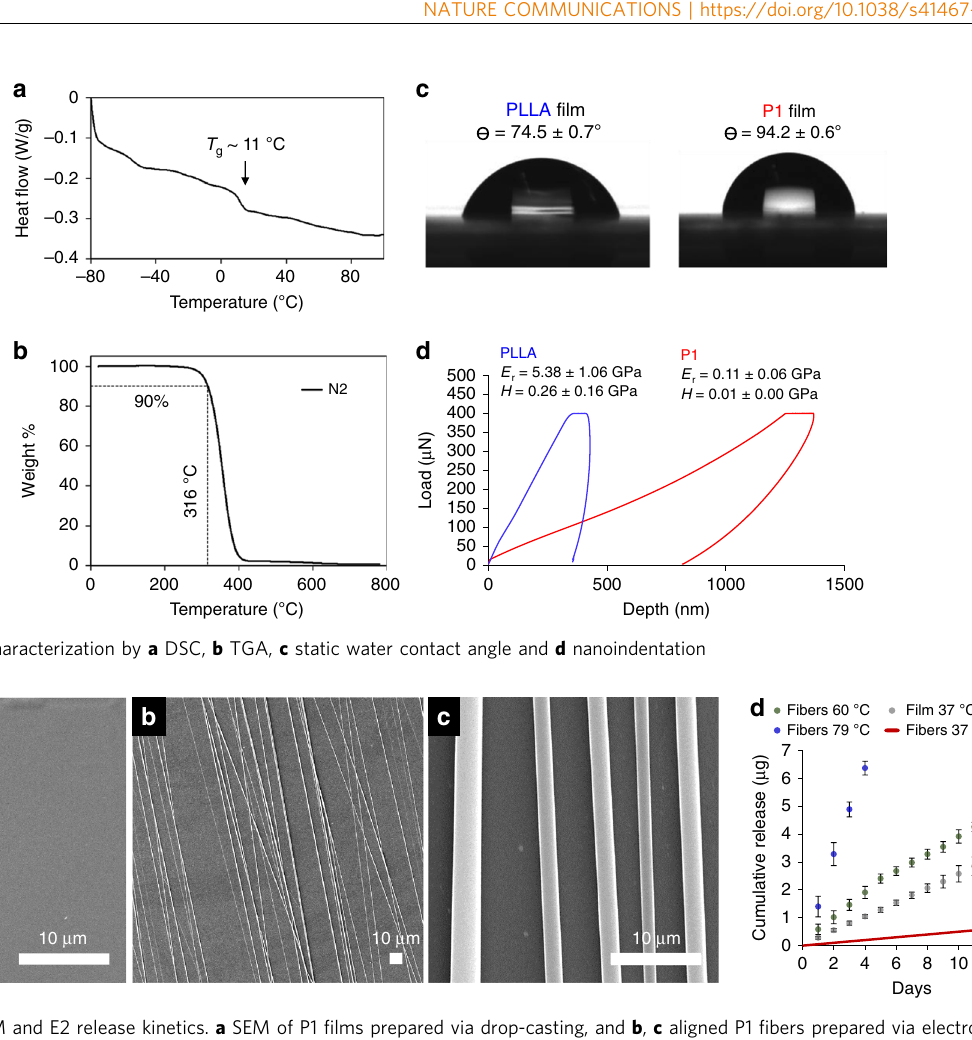
Fig. 5 P1 material SEM and E2 release kinetics. a SEM of P1 fi lms prepared via drop-casting, and b , c aligned P1 fi bers prepared via electrospinning. d Cumulative E2 release from P1 fi bers and fi lms in PBS ( n ≥ 3, all values are mean ± std. dev., all SEM scale bars are 10 µ